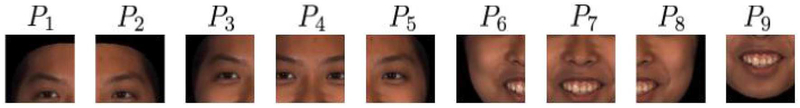
Cropped patches from 3D registered face images.